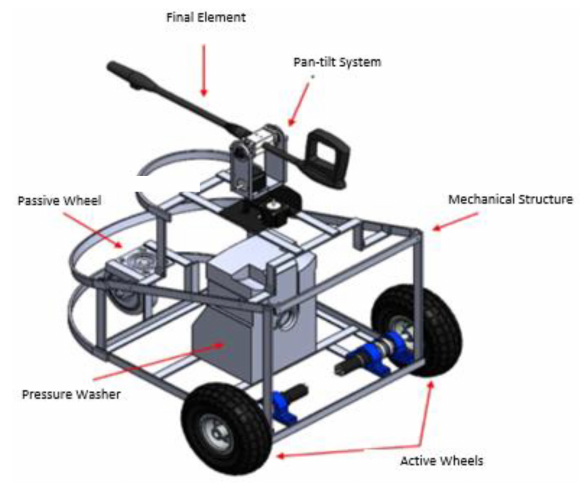
Figure 2. Pressure cleaning